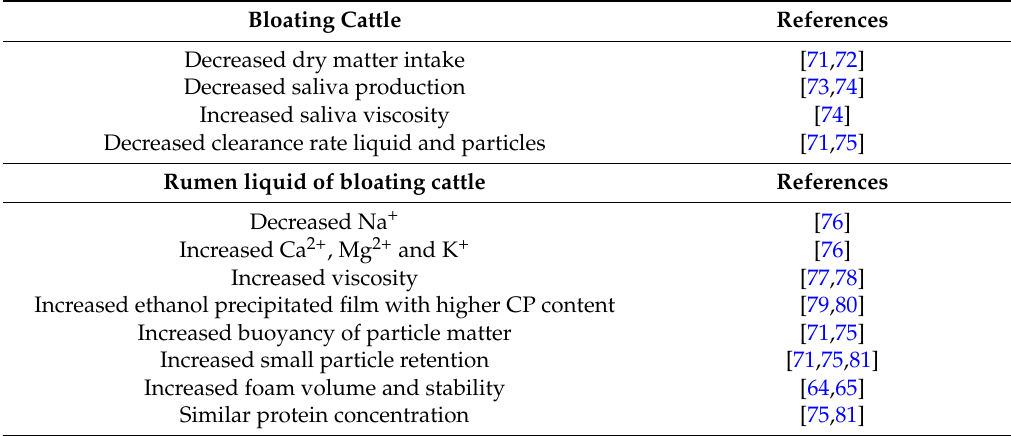
Table 3. Characteristics of cattle prone to pasture bloat compared with non-bloating animals. Bloating